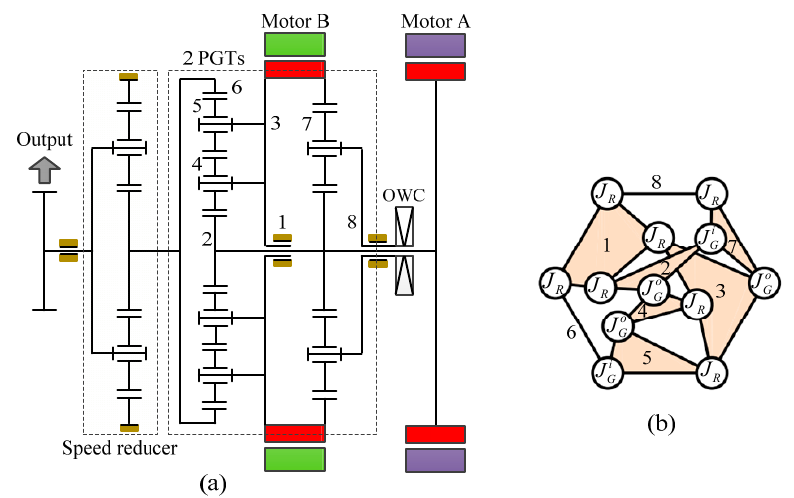
Figure 2. NSK’s hybrid transmissions: ( a ) Schematic diagram; ( b ) Corresponding